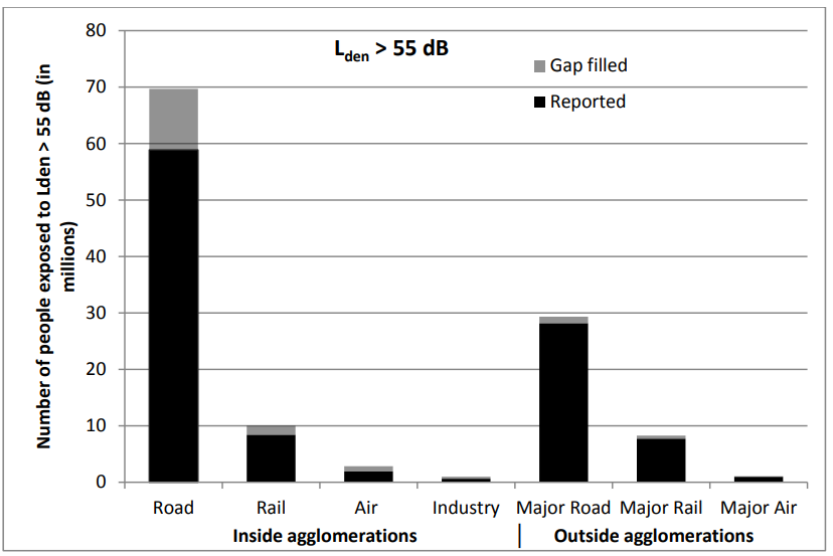
Figure 1. The number of people exposed to environmental noise in Europe L den > 55 dB in 28 EU member states in 2012, in and outside the urban agglomerations [6]. Note: Gap filing has been carried out based on the methodology published in “Noise in Europe 2014”, available at http://www.eea.europa.eu/publications/noise-in-europe-2014.